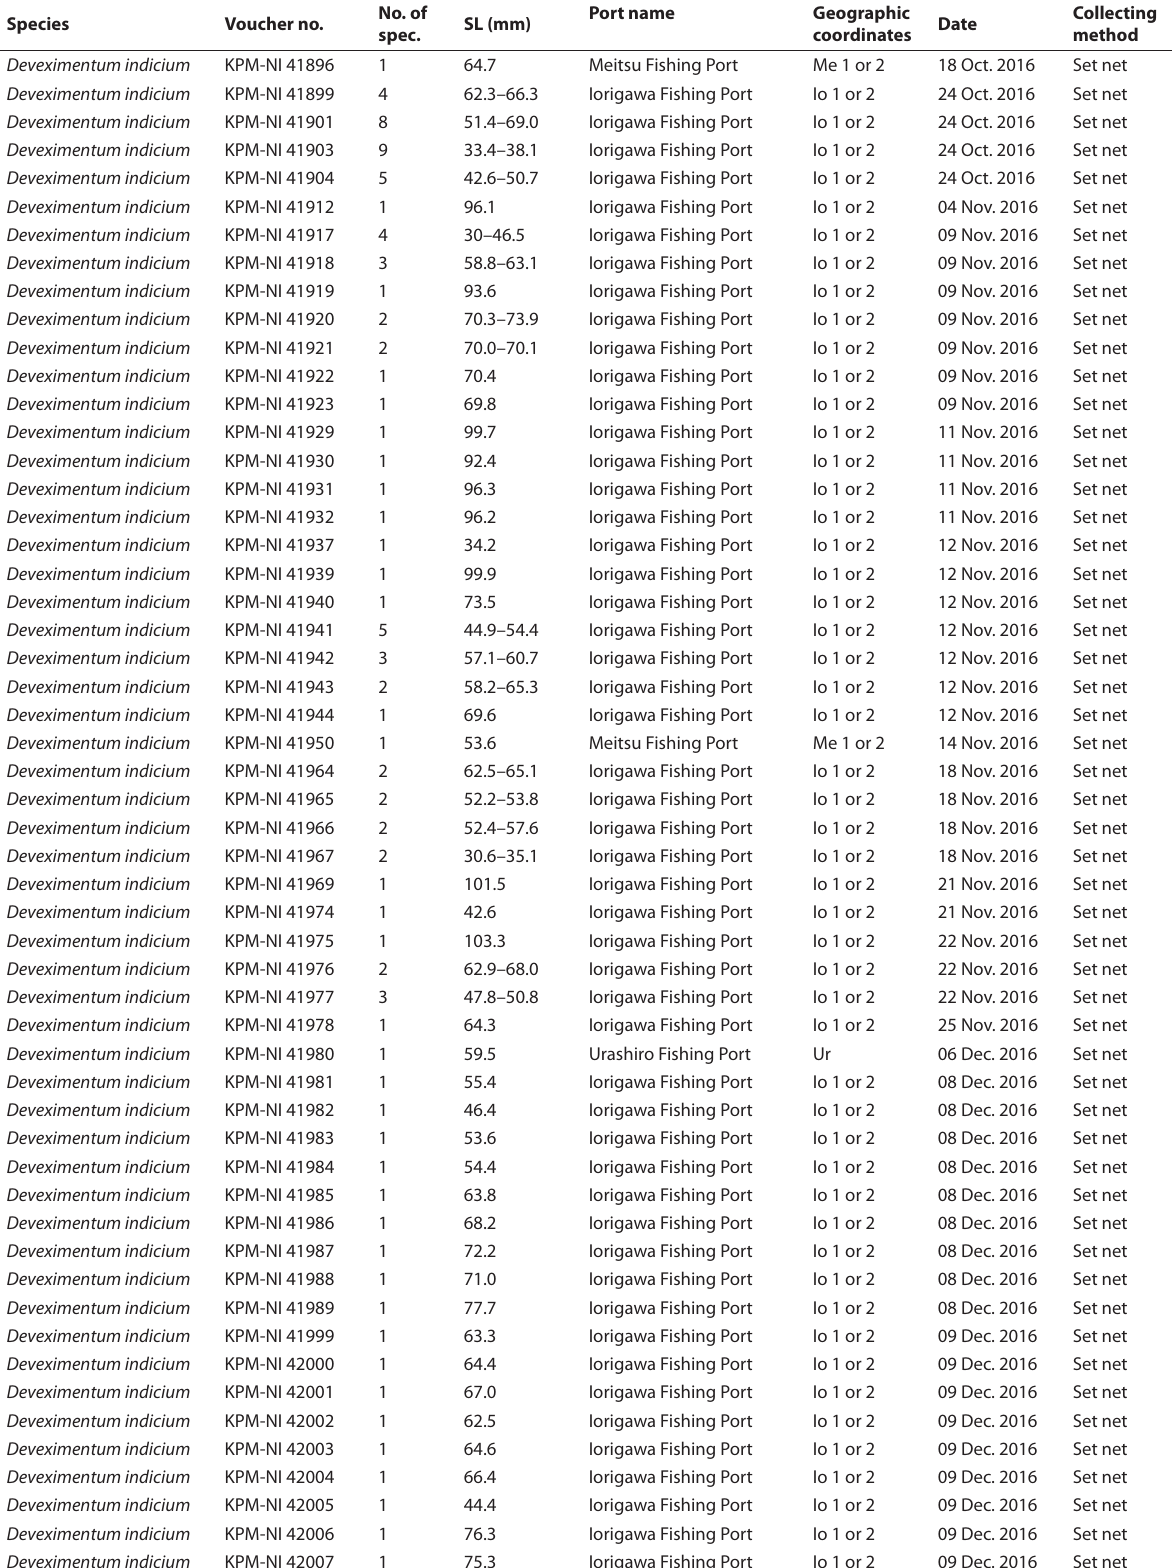
Table A1. List of specimens of Leiognathidae of Miyazaki Prefecture. Abbreviations of geographic coordinates indicate the following loca- tions: Ur, mixed catch from 2 set nets, 32°39’30”N, 131°50’02”E, ca 30 m depth and 32°39’20”N, 131°49’10”E, ca 30 m depth; Io 1,